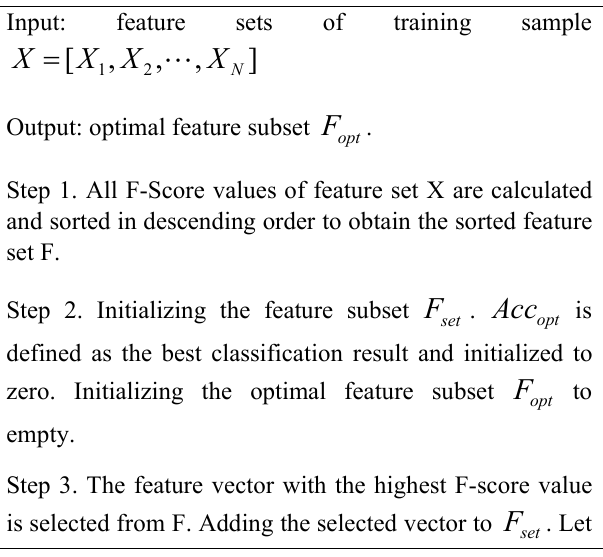
Algorithm 1 . F-score feature selection method